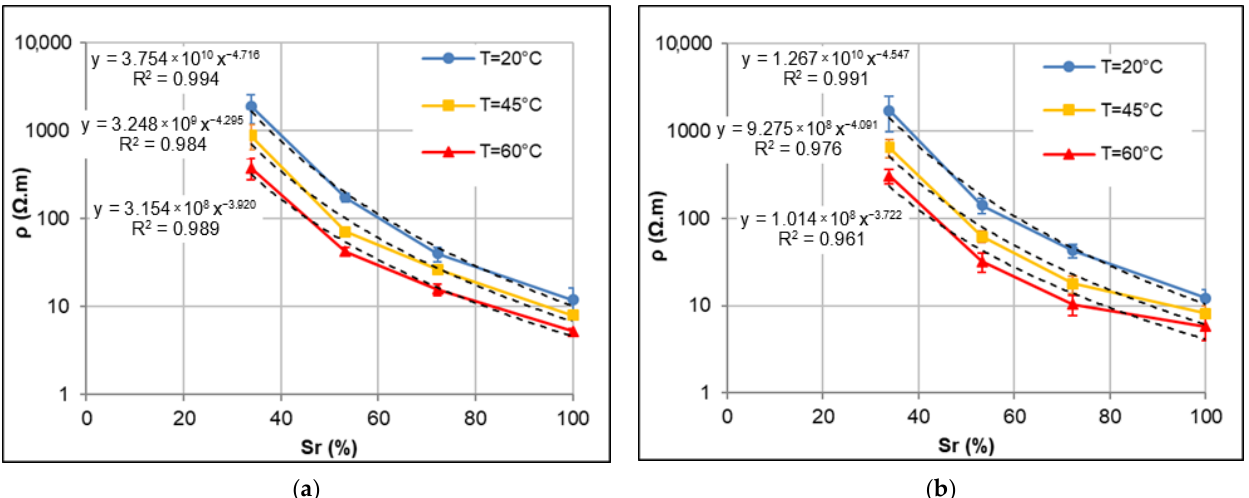
Figure 5. Calibration curves of resistivity* vs. degree of saturation at different temperatures: ( a ) transmission configuration; ( b ) Wenner configuration. * Resistivity data are averaged over all specimens except S2.